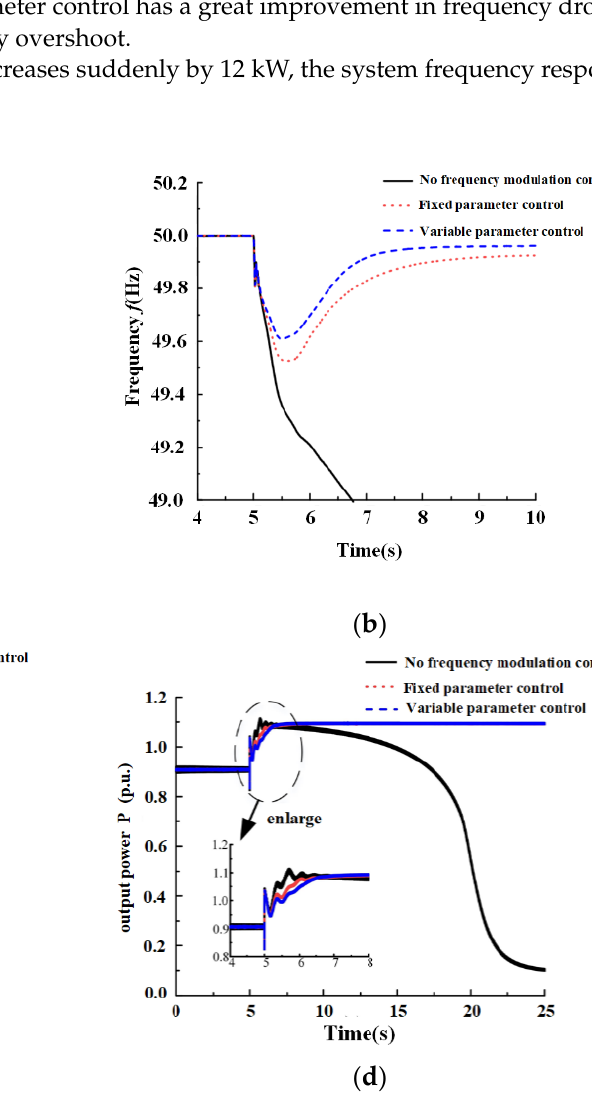
Figure 16. Comparison simulation curve of frequency modulation control with a load increase of 12 kW. ( a ) The demand load curve. ( b ) System frequency response curve. ( c ) Wind-driven generator output active power response curve. ( d ) Conventional generator output active power response curve.